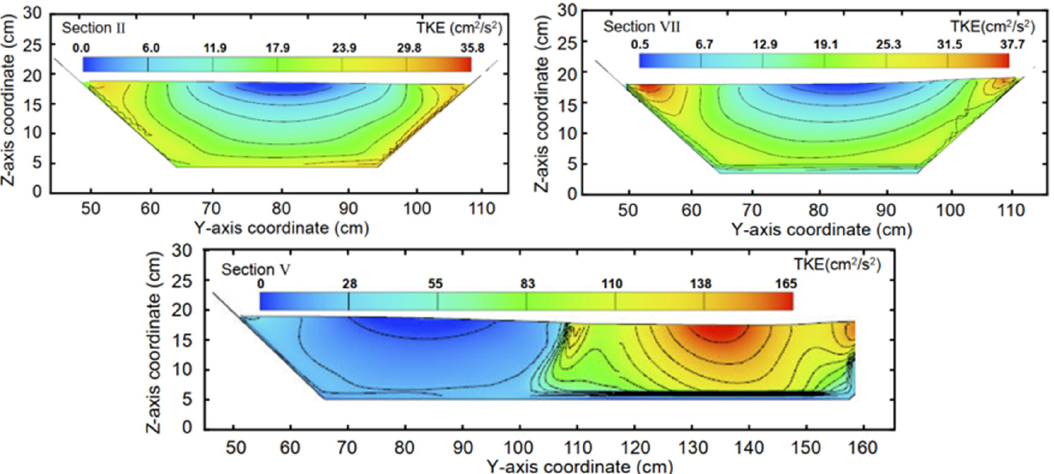
Figure 9. Turbulent kinetic energy (TKE) contour map on different sections.